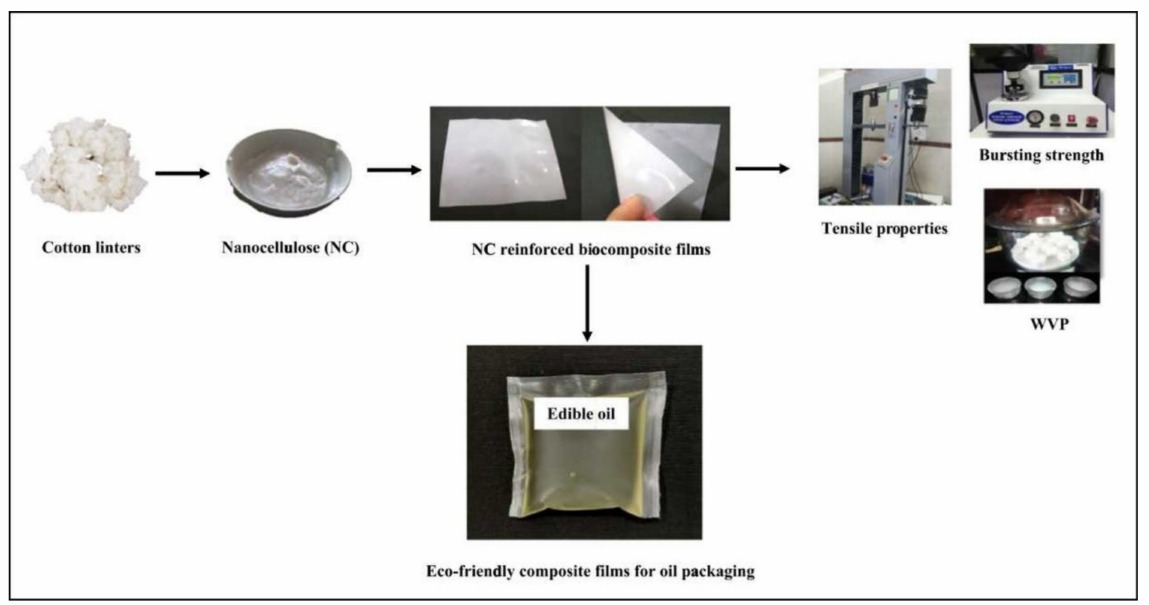
Figure 14. The schematic of the fabrication of eco-friendly composite films for oil packaging. Reprinted with permission from Ref. [158]. License Number: